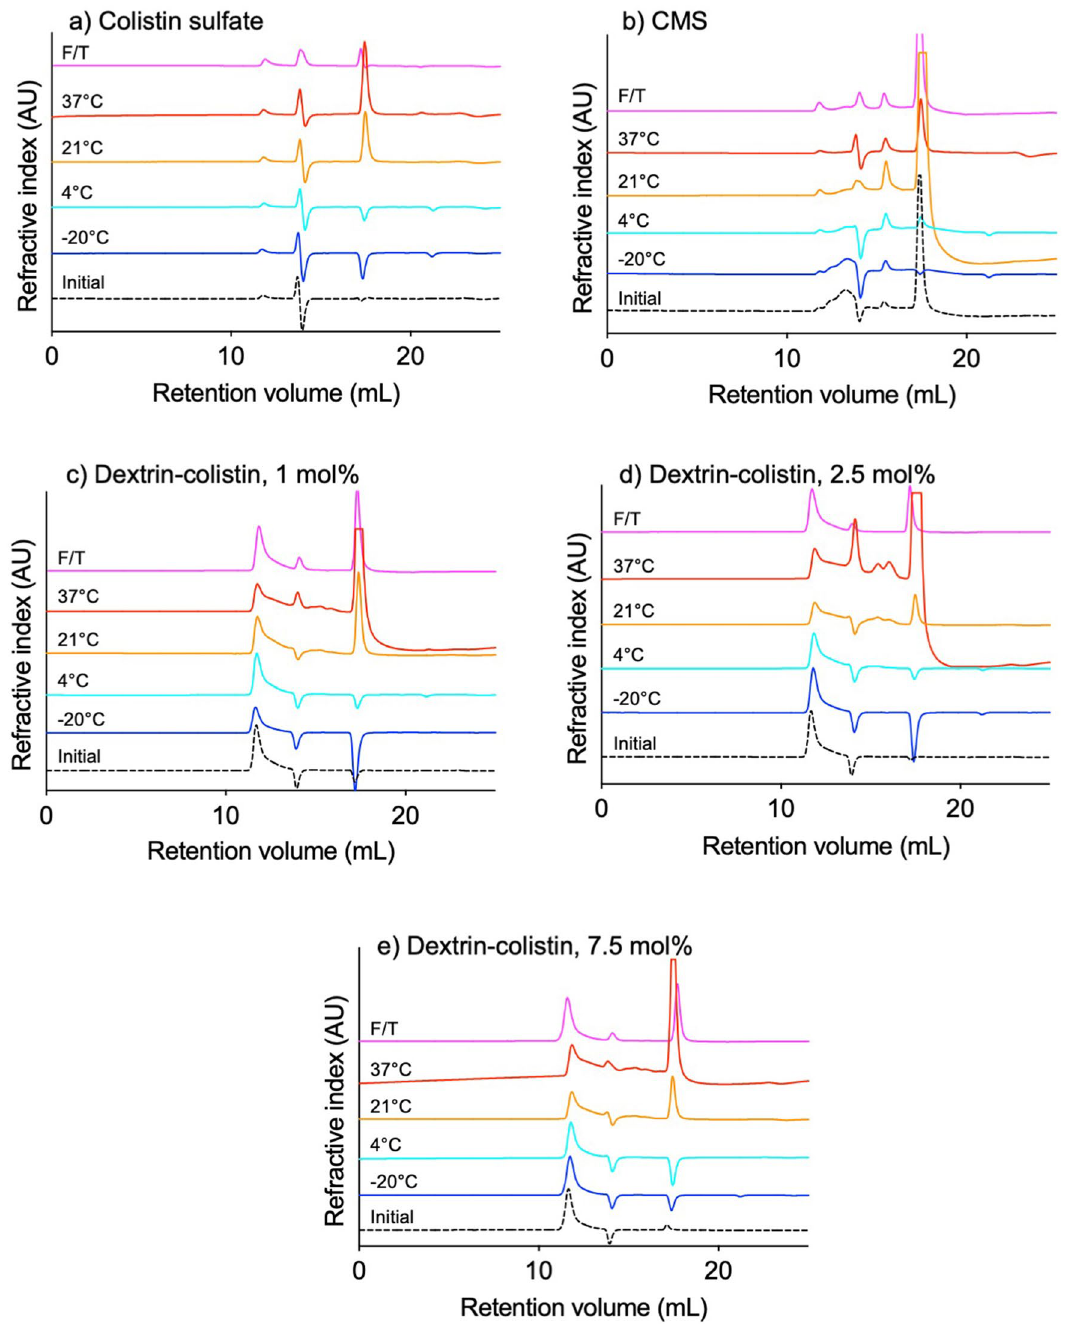
Figure 1. GPC chromatograms showing refractive index (RI) of ( a ) colistin sulfate, ( b ) colistimethate sodium (CMS) and dextrin–colistin conjugates with ( c ) 1 mol%, ( d ) 2.5 mol% and ( e ) 7.5 mol% succinoylation before (dotted line) and following storage at − 20 (dark blue line), 4 (light blue line), 21 (yellow line) or 37 (red line)°C for 12 months, or exposed to weekly freeze-thawing for 5 weeks (pink